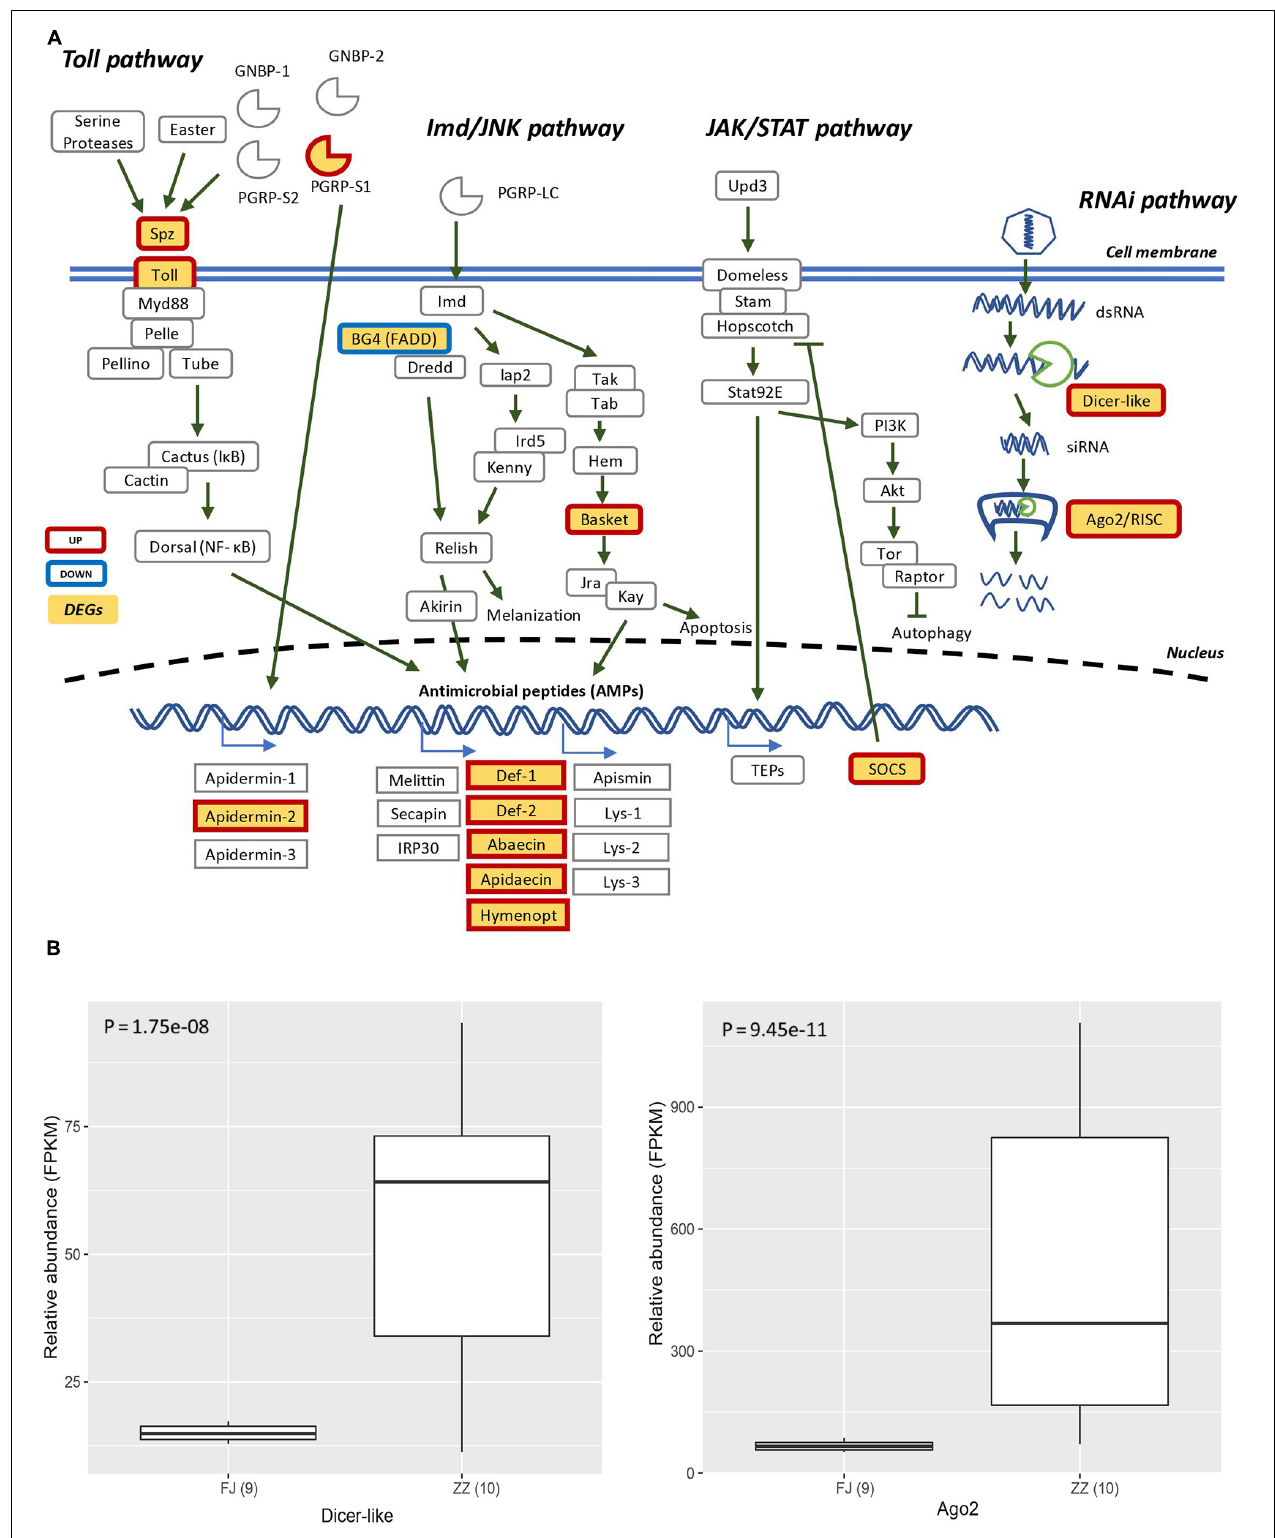
FIGURE 6 | (A) The Signaling pathway of the canonical innate immune response of the honey bee. The pathways are those including Toll pathway, Imd/JNK pathway, JAK/STAT pathway, and RNAi pathway. The genes filled with yellow are differentially expressed genes (DEGs). The genes with red border are upregulated, and the genes with blue border are downregulated. (B) The DEGs (Dicer-like and Ago2) were involved in RNA interference (Dicer-like: P = 1.75e–08; Ago2: P = 9.45e–11).